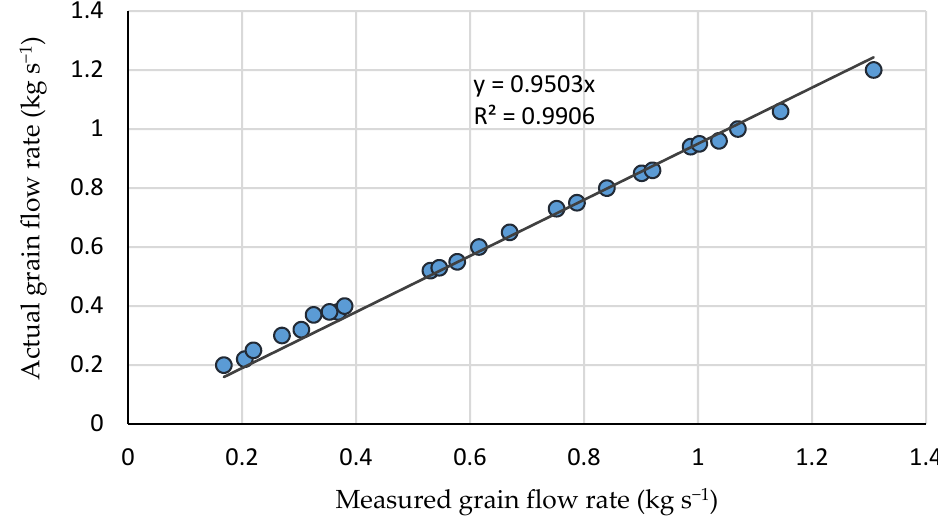
Figure 5. Measured and actual grain flow rates.